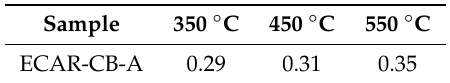
Table 3. Average Schmid factor (SF) of basal < a > slip under uniaxial tension along RD for the ECAR-CB-A samples at di ff erent final rolling